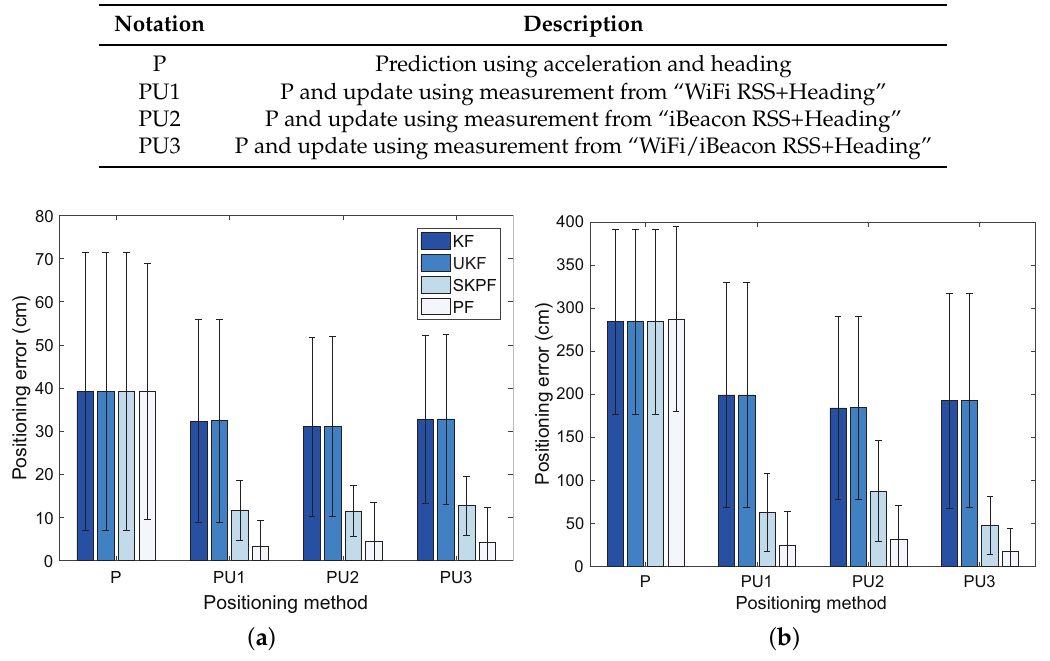
Table 1. Positioning Methods for the Experimental Tests.